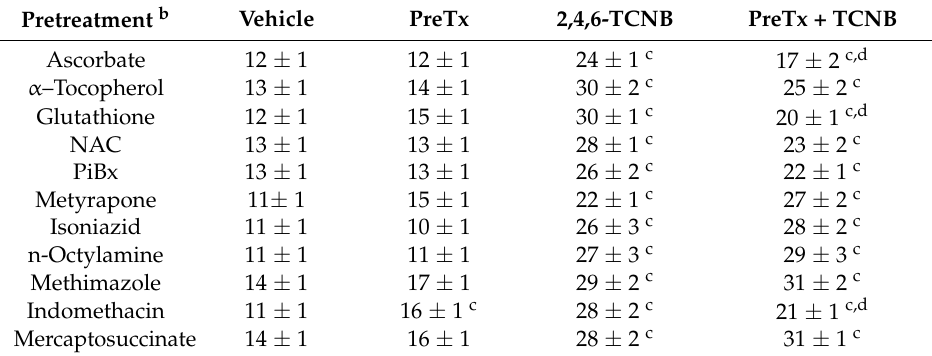
Table 3. Effect of antioxidants and metabolism inhibitors on 2,4,6-TCNB cytotoxicity a . Pretreatment